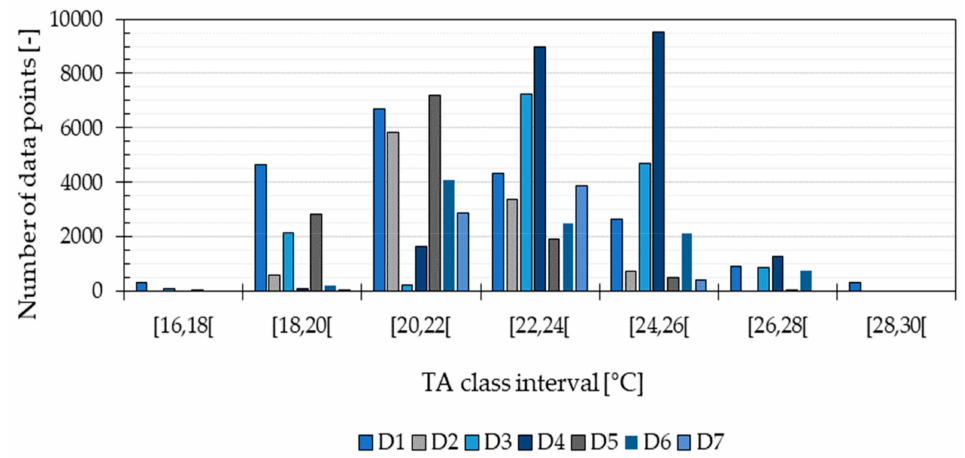
Figure 2. Number of data points in each TA class obtained from all the dwellings (D1, D2, D3, D4, D5, D6 and D7), considering BR and LR together.